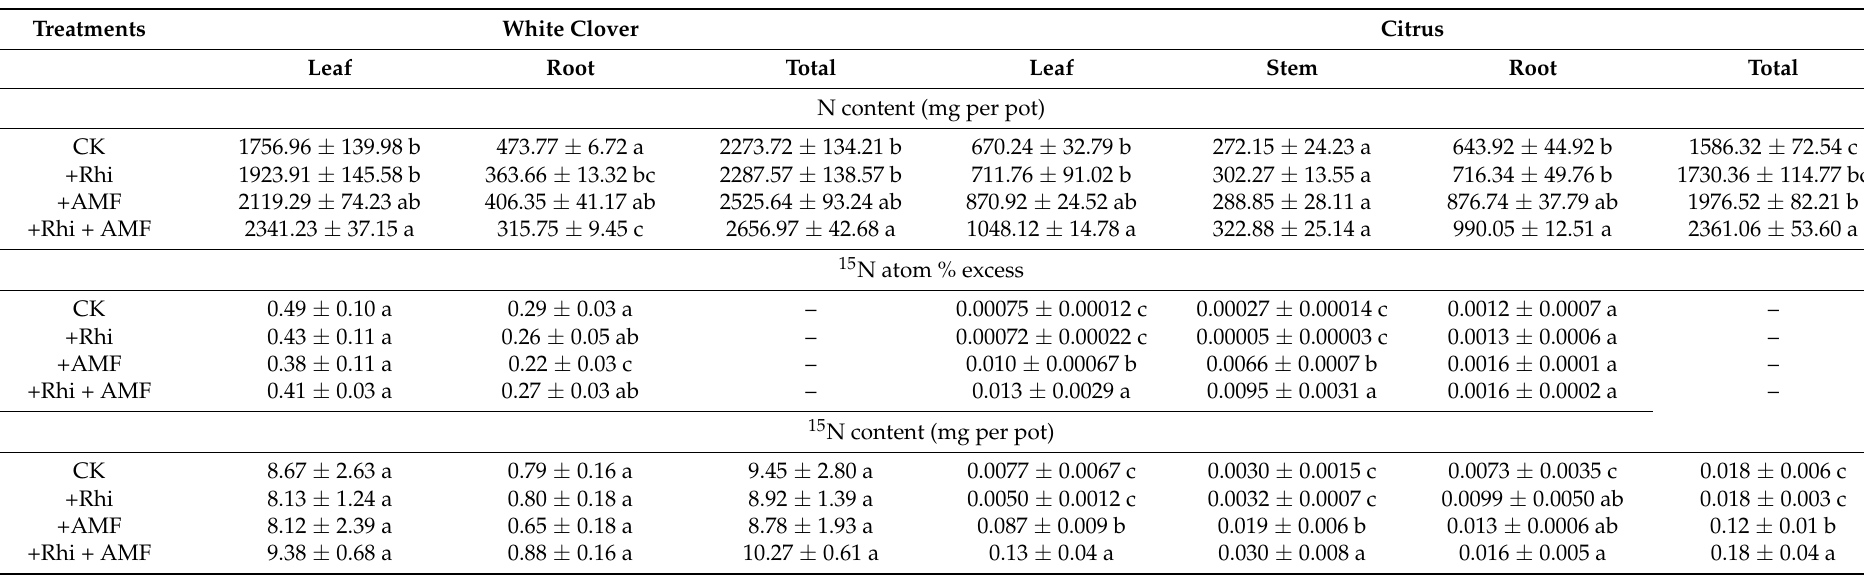
Table 5. N content (mg per pot), 15 N atom % excess, 15 N content (mg per pot) in various parts of white clover and citrus grown in pots. White clovers were labeled with ( 15 NH 4 ) 2 SO 4 for 14 days before